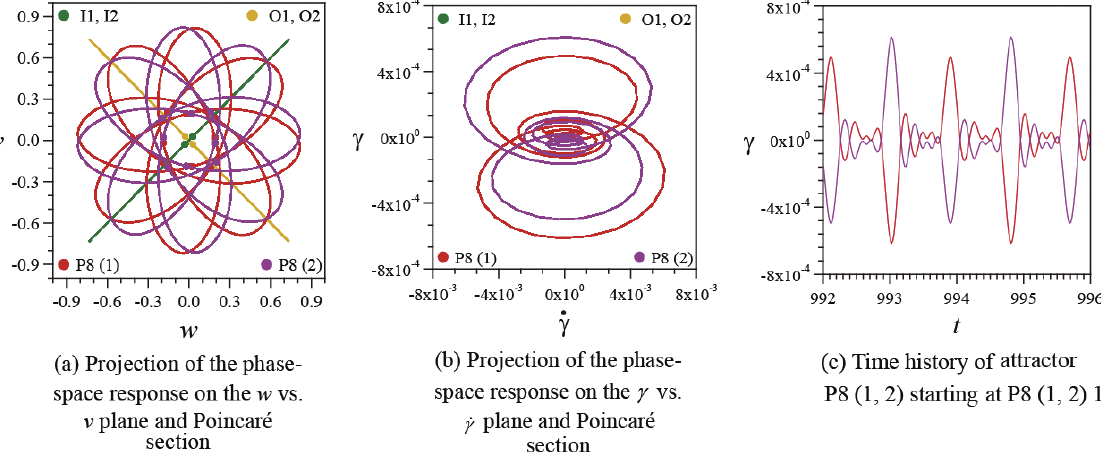
Fig. 7. Coexisting non-trivial solutions at q u = 1.00 and Ω u = 2 ω 0 .